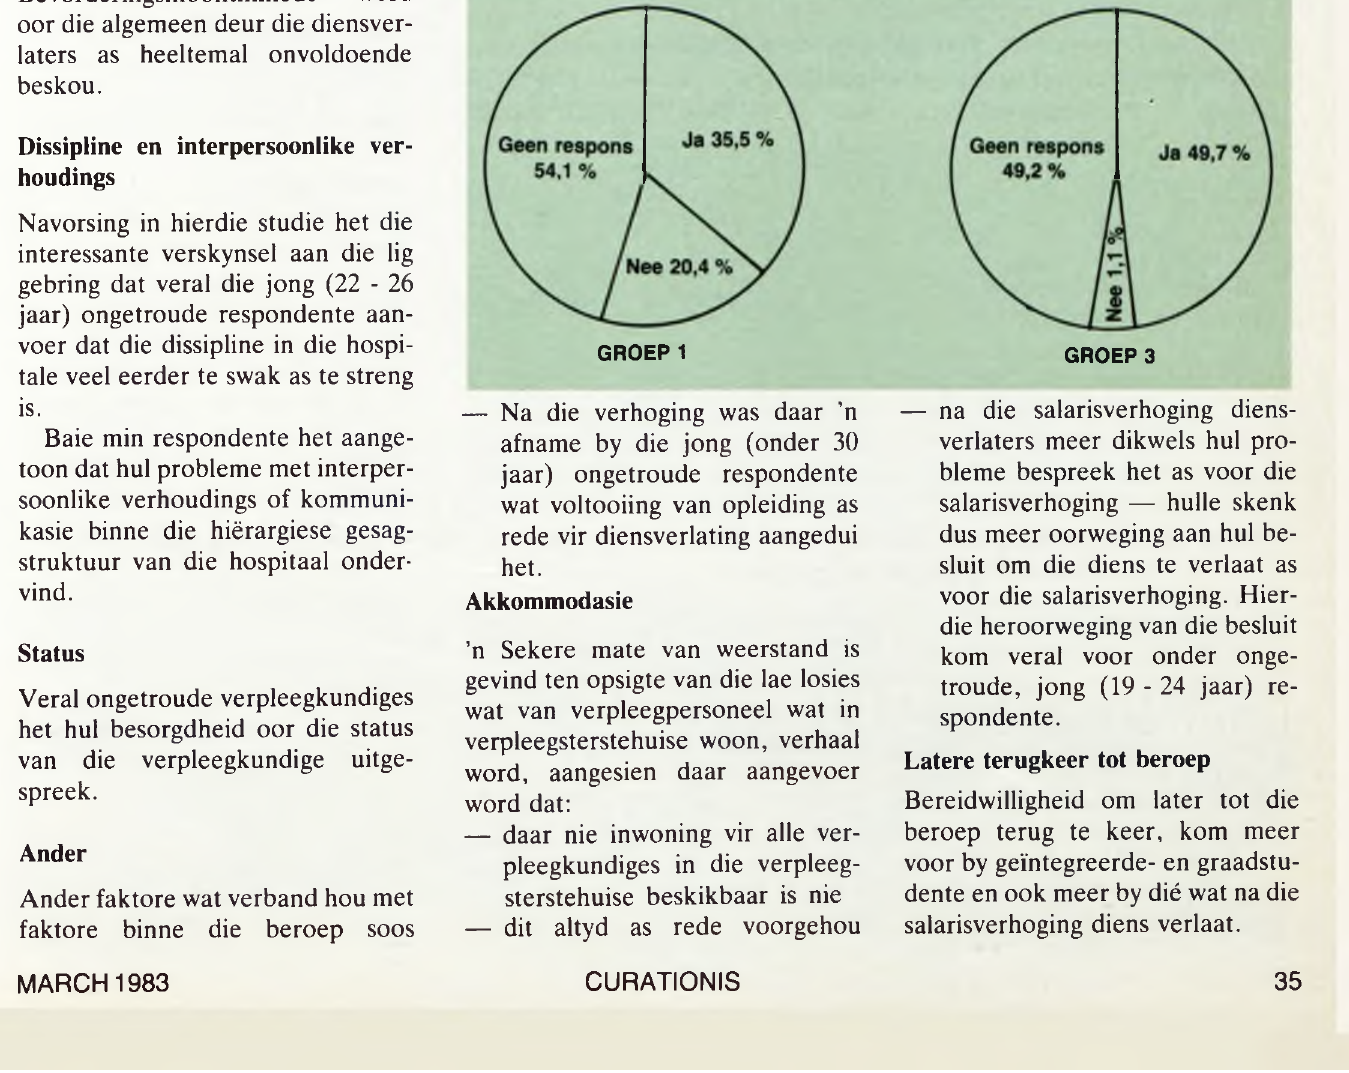
Figuur 3: ’n Vergelyking om die verskille aan te toon tussen die diensverlaters (1 Jan — 31 Mrt 1979) en die aanblyers (1 Jan — 31 Mrt 1979) t.o.v. die bespreking van